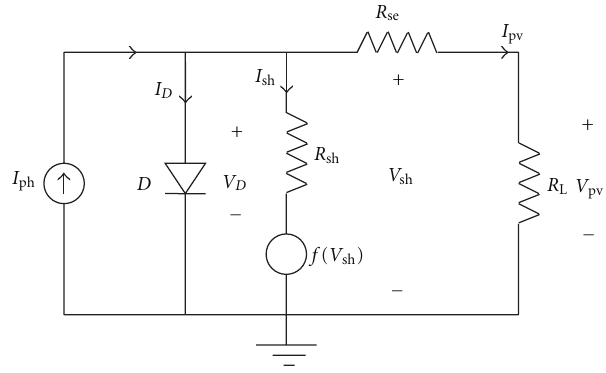
Figure 7: Bishop’s model to represent the SPVA under partial shaded